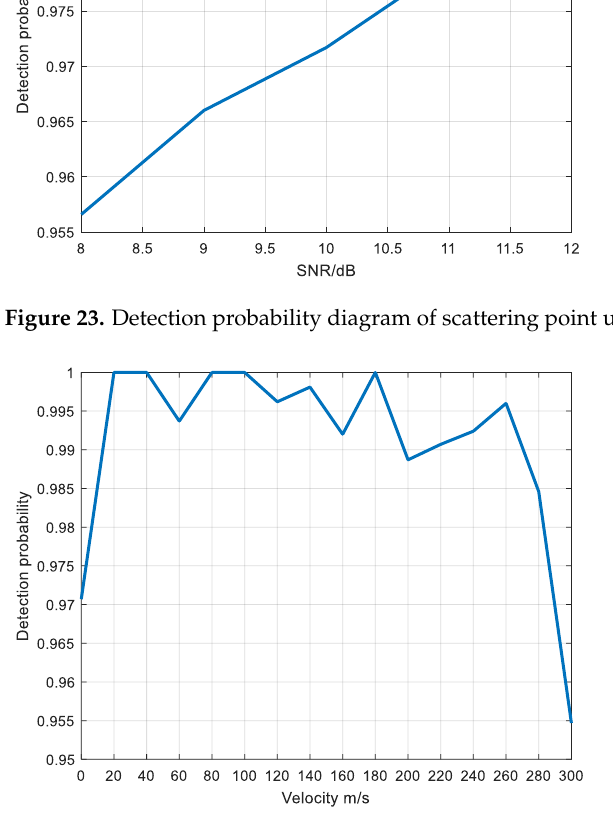
Figure 24. Detection probability diagram of scattering point under different speeds.